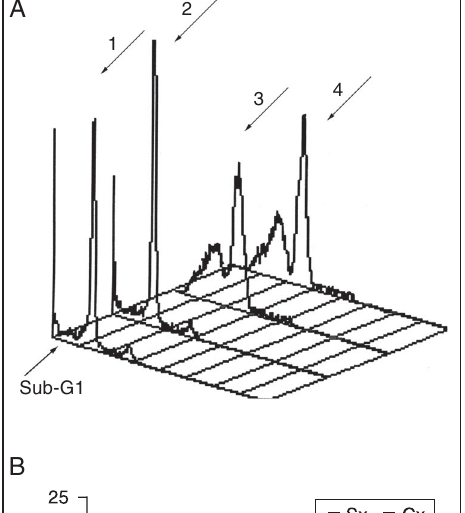
Figure 4. Increased percentage of cycling cells (cells in the S/ G2M phases of the cell cycle) in concanavalin A-stimulated thy- mocyte cultures from adult rats orchidectomized at the age of 30 days (Cx) as determined by pro- pidium iodide binding to DNA. A , Representative overlaid histo- grams (3-D view) of propidium iodide staining of cells from thy- mocyte cultures of 1) 2-month- old control rats (Sx), 2) 2-month- old Cx rats, 3) 10-month-old Sx rats, and 4) 10-month-old Cx rats. The arrow points at the sub- G1 peak that corresponds to apoptotic cells. B , Relative pro- portion of thymocytes in the S/ G2M phases of the cell cycle in concanavalin A-stimulated thy- mocyte cultures from control rats (Sx) and rats orchidectomized at the age of 30 days (Cx). Data are reported as means ± SEM for N = 5. *P < 0.05 and **P < 0.01 (Mann-Whitney